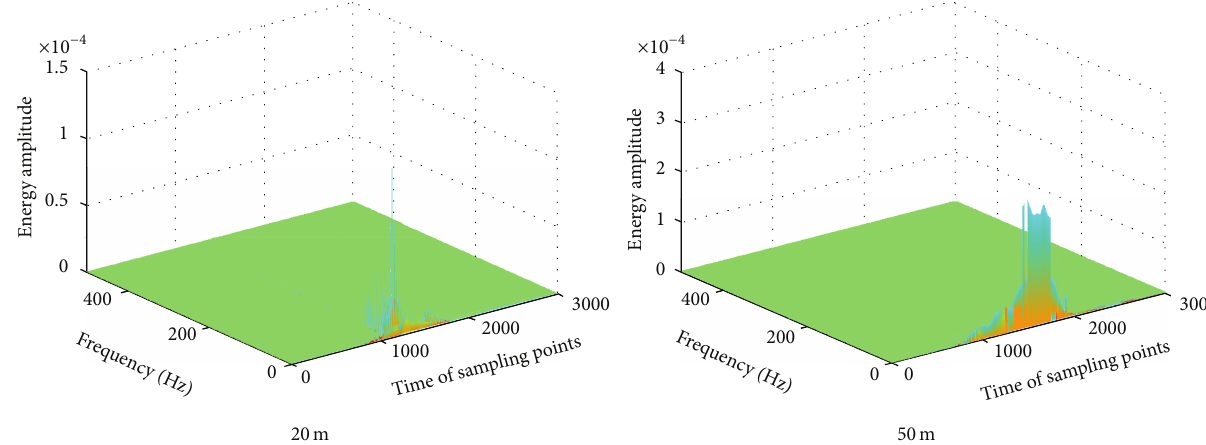
Figure 16: Three-dimensional energy spectrum of vibration signals at different measuring